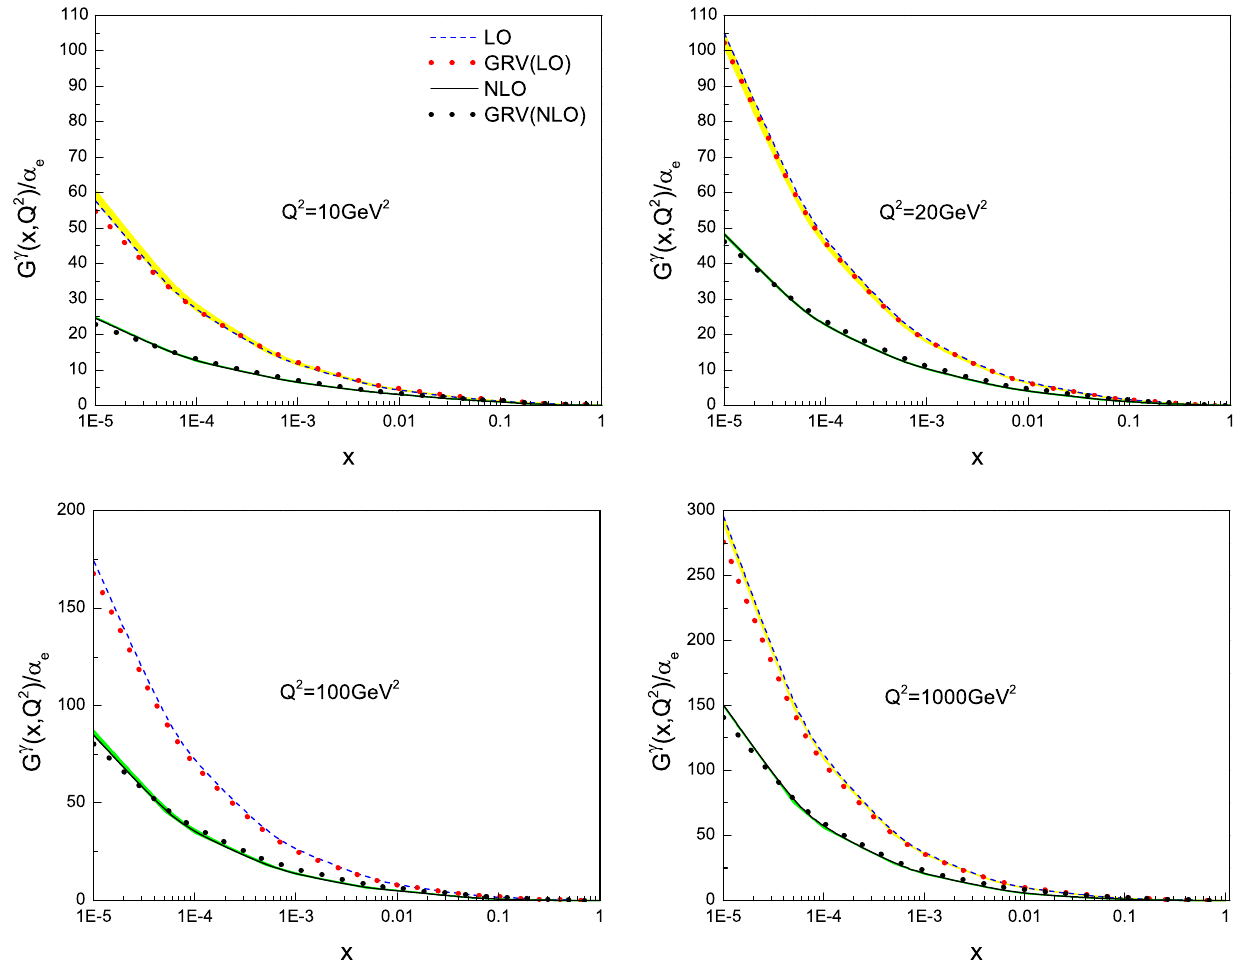
Fig. 3 The gluon distribution function of the photon at scales Q 2 = 10 , 20 , 100 and 1000 GeV 2 in LO and NLO in comparison with the GRV